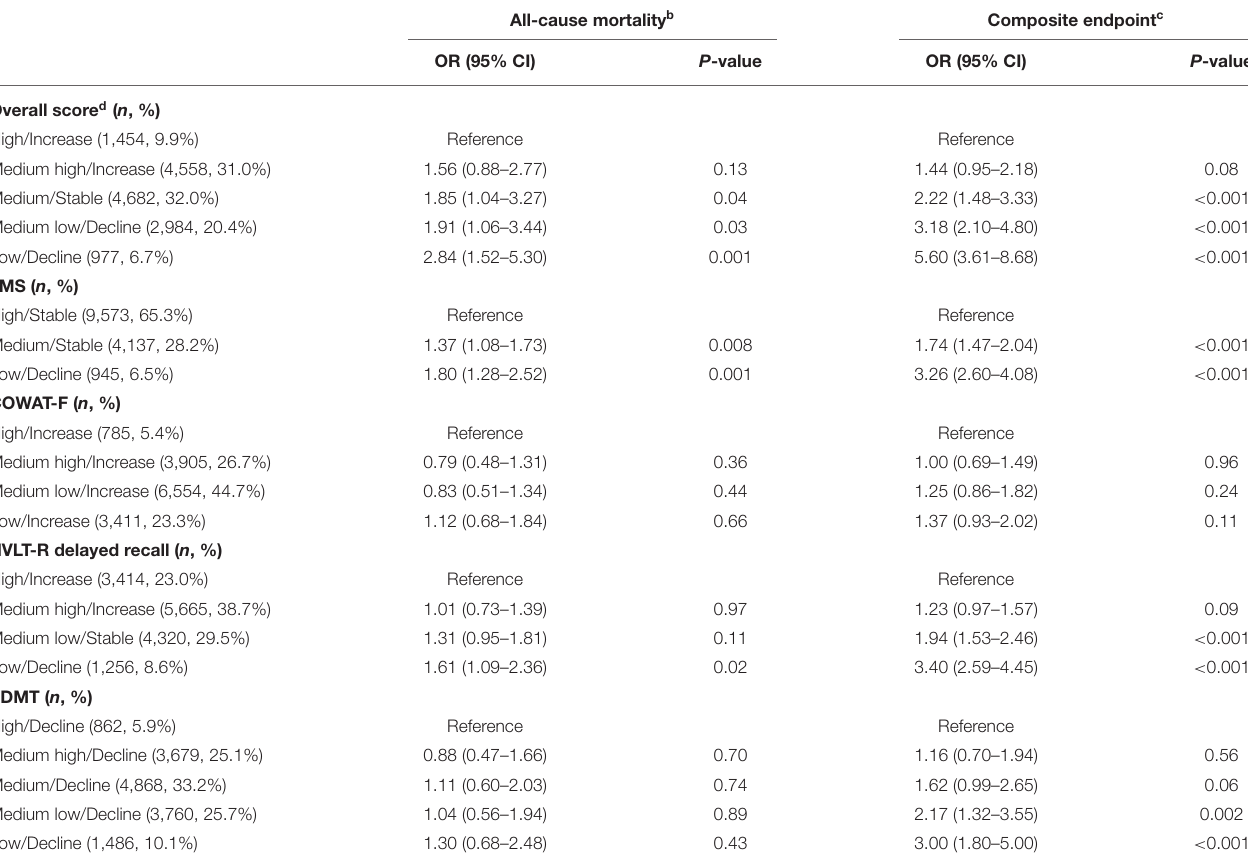
TABLE 3 | Fully adjusted a associations of cognitive trajectories with incident all-cause mortality and the composite endpoint ( n =